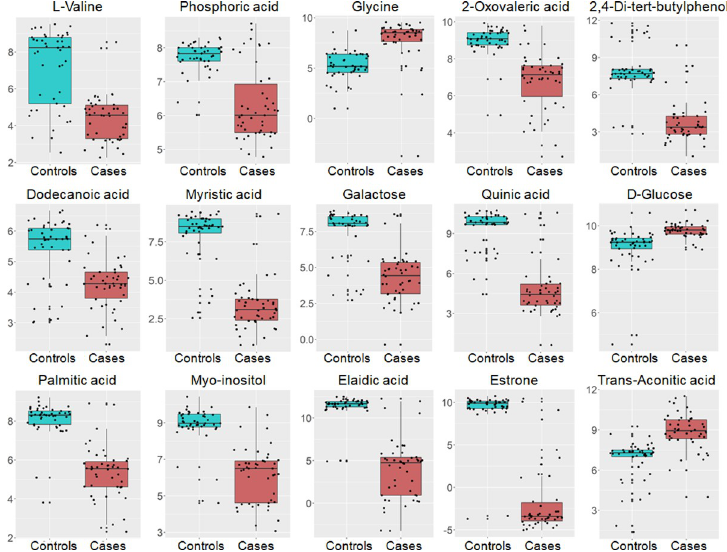
Fig 6. Regulatory pattern of plasma metabolites associated with AVS in patients and control individuals. Data from plasma candidate metabolites in the 46 AVS cases (orange boxes) and 46 controls (blue boxes) are shown. Data are normalized to the internal standard (2-isopropylmalic acid) and log transformed. The boxplots show the median and the inter-quartile range for each metabolite in the two